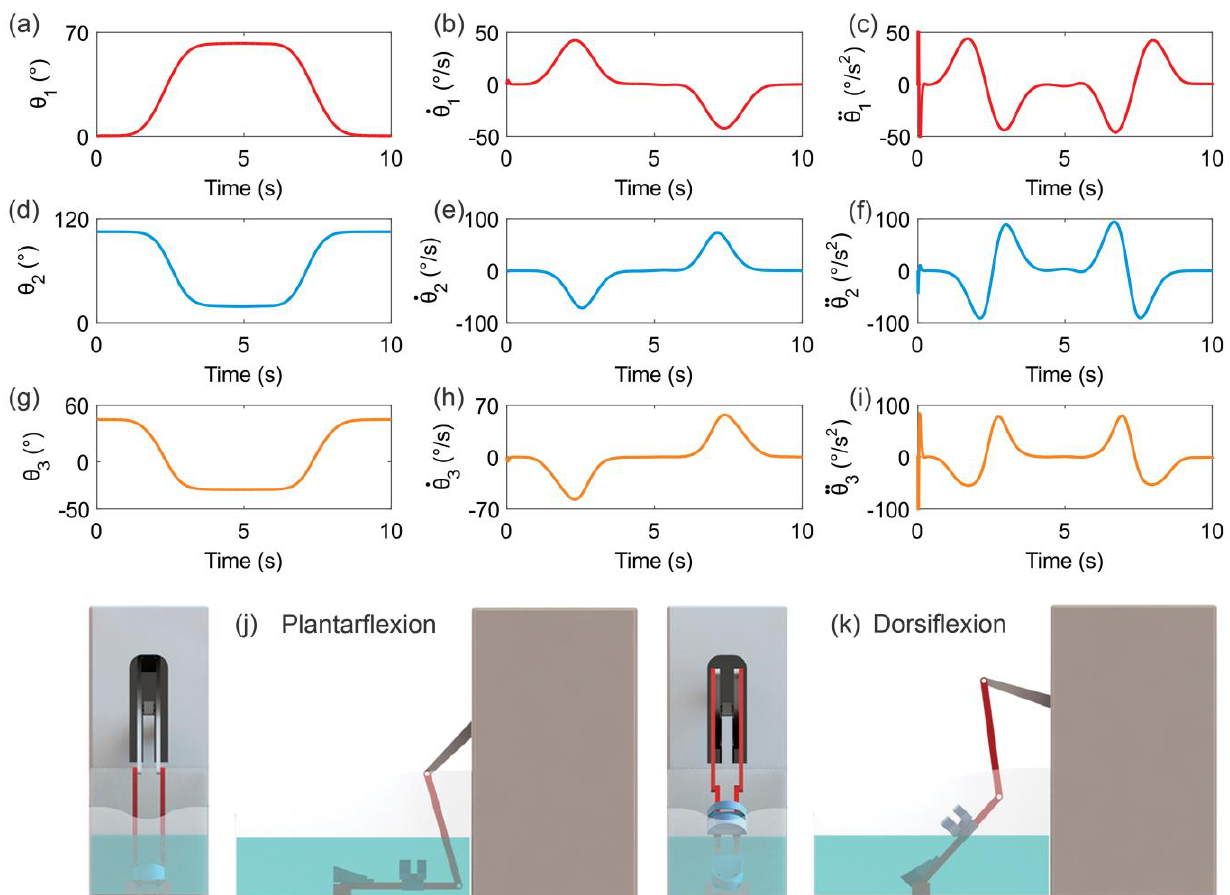
Figure 10. Ankle rehabilitation robot response. ( a – c ) are respectively the angular position, velocity, and acceleration of θ 1 , ( d – f ) are respectively the angular position, velocity, and acceleration of θ 2 , ( g – i ) are respectively the angular position, velocity, and acceleration of θ 3 , ( j ) is the plantarflexion position, and ( k ) is the dorsiflexion position.